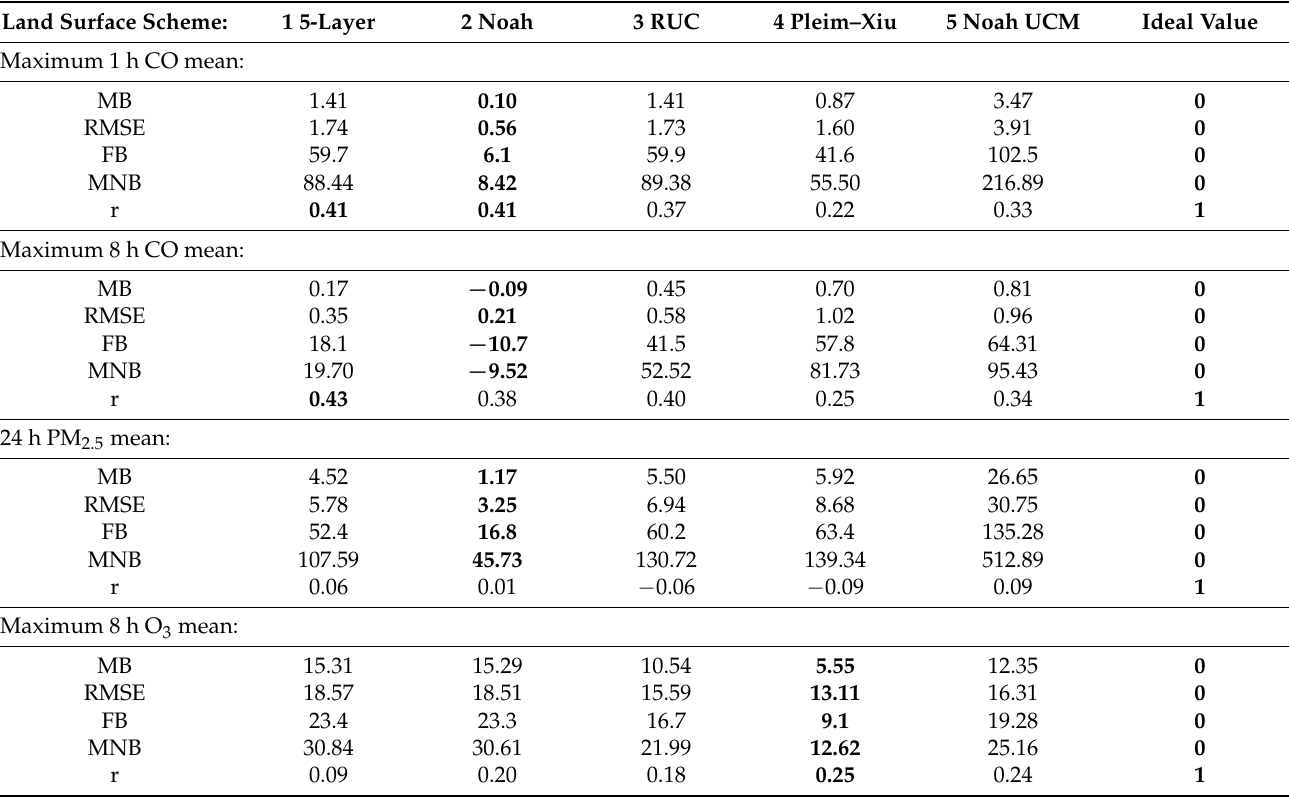
Table 7. Metrics for short-term air quality modeling. Bold numbers highlight the schemes with the best performances.